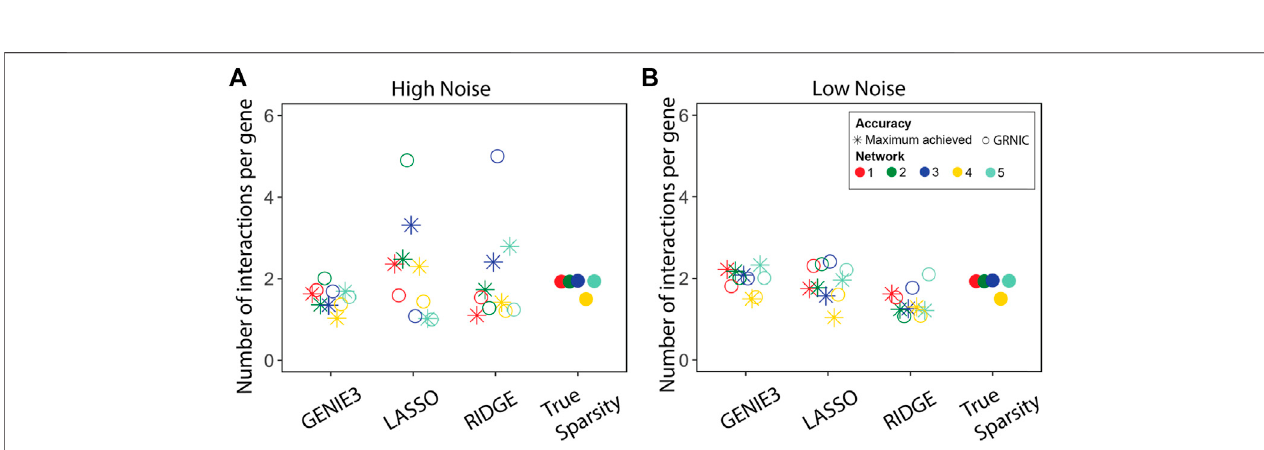
FIGURE 3 | Performance evaluation of the sparsity selection pipeline in terms of sparsity. The sparsity of the inferred GRNs (the GRN having the maximum F1- score,andtheoneselectedbyGRNIC)isshownintermsoftheaveragenumberoflinksfor (A) highand (B) lownoiselevelsforthe fi venetworks.Thesparsitiesofthe fi ve true GRNs are shown in an extra column to the